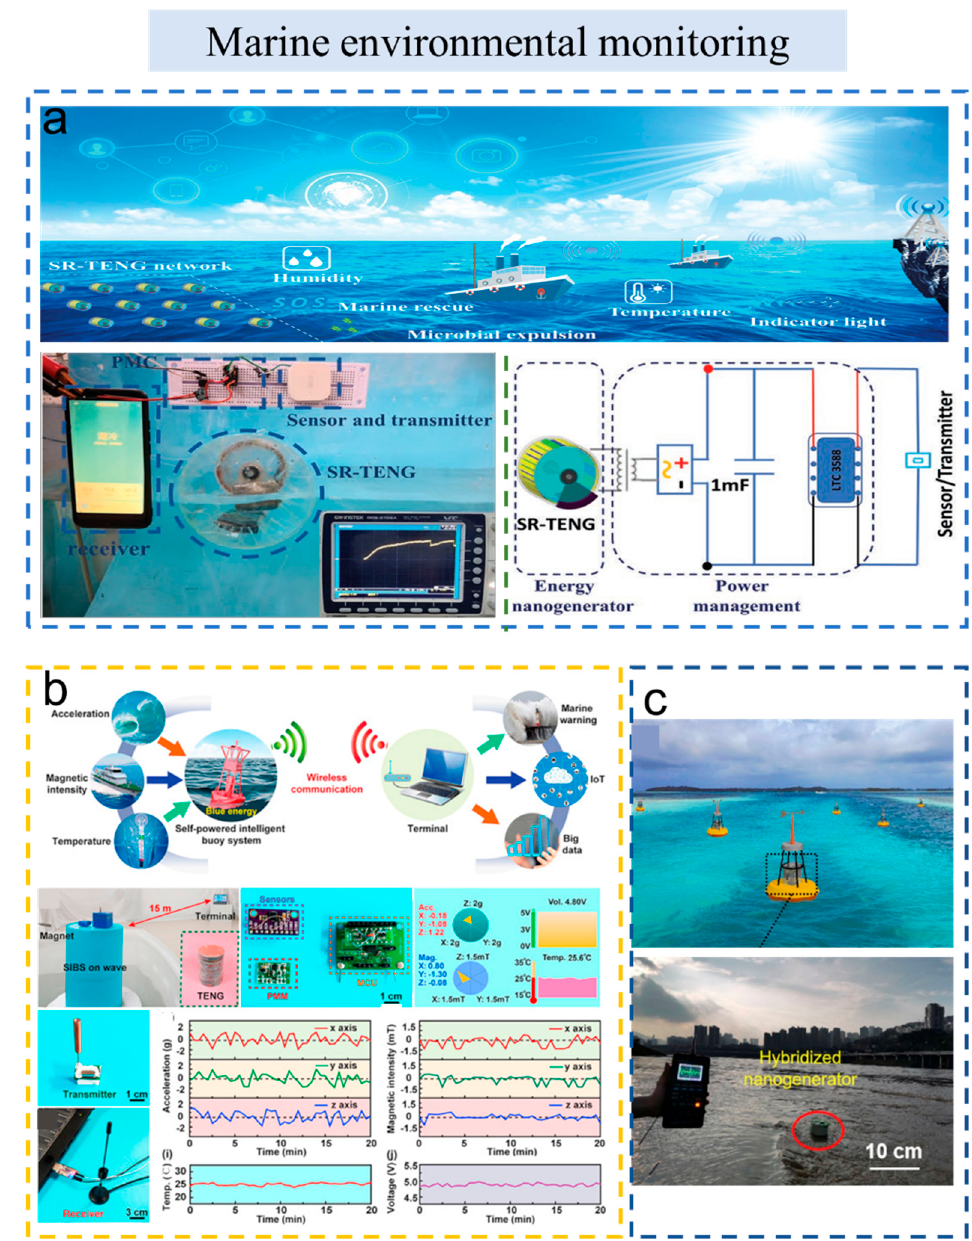
Figure 4. The self-powered wireless sensors and systems based on TENG used in marine environmental monitoring. ( a ) A self-powered and wireless hydrological information monitoring system. Reproduced with permission [66]. Copyright 2022, John Wiley & Sons. ( b ) Self-powered intelligent buoy system by water wave energy for sustainable and autonomous wireless sensing and data transmission. Reproduced with permission [67]. Copyright 2019, Elsevier Ltd. ( c ) A chaotic pendulum triboelectric–electromagnetic hybridized nanogenerator for wave energy scavenging and self-powered wireless sensing system. Reproduced with permission [68]. Copyright 2020, Elsevier Ltd.